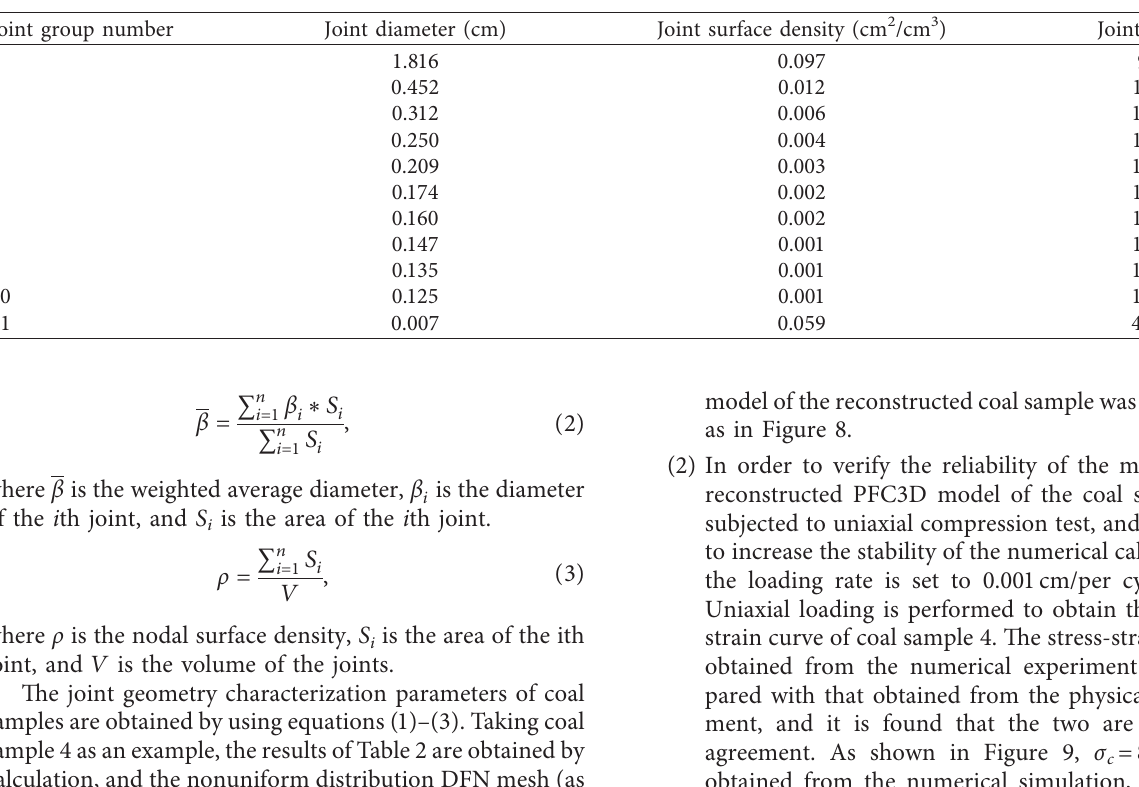
Table 1: Parameters of geometric characteristics of coal sample 4